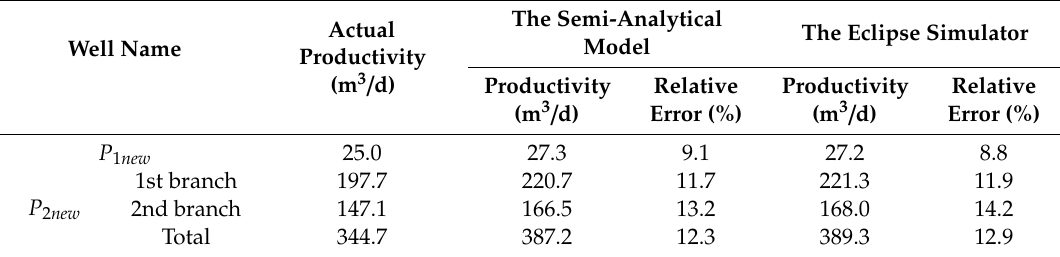
Table 3. Results comparison of two methods.